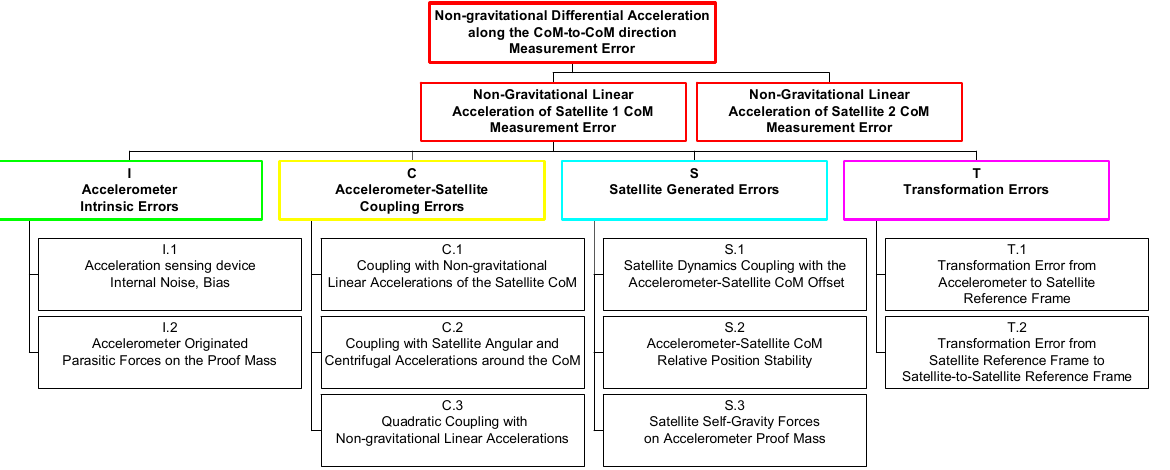
Figure 9. Error tree for the measurement of the non-gravitational differential acceleration along the satellite’s CoM-to-CoM